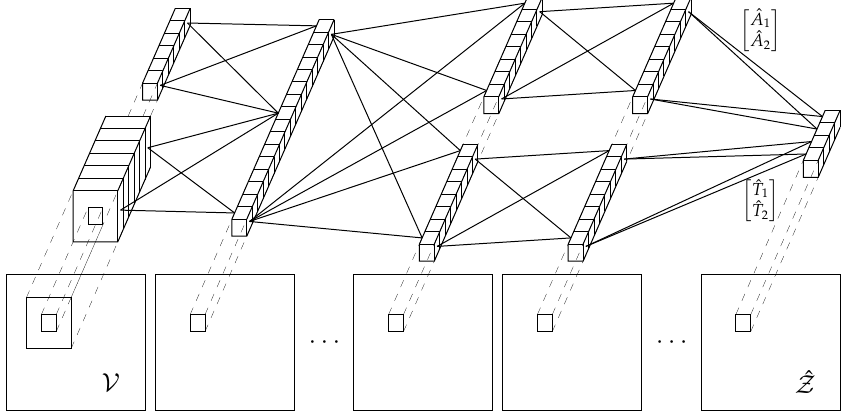
Figure 4. Predictive model